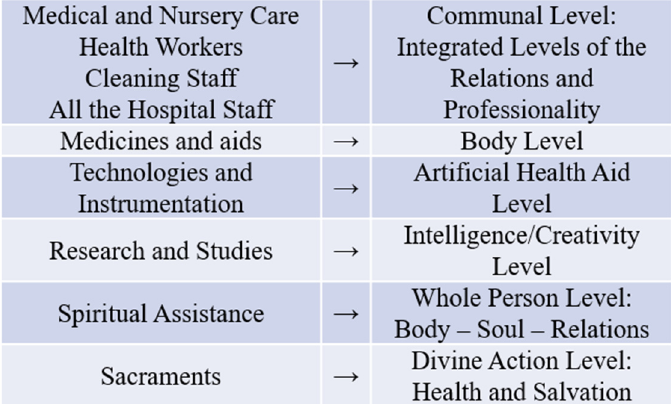
Figure 1. Multiple level extension of the care approach.